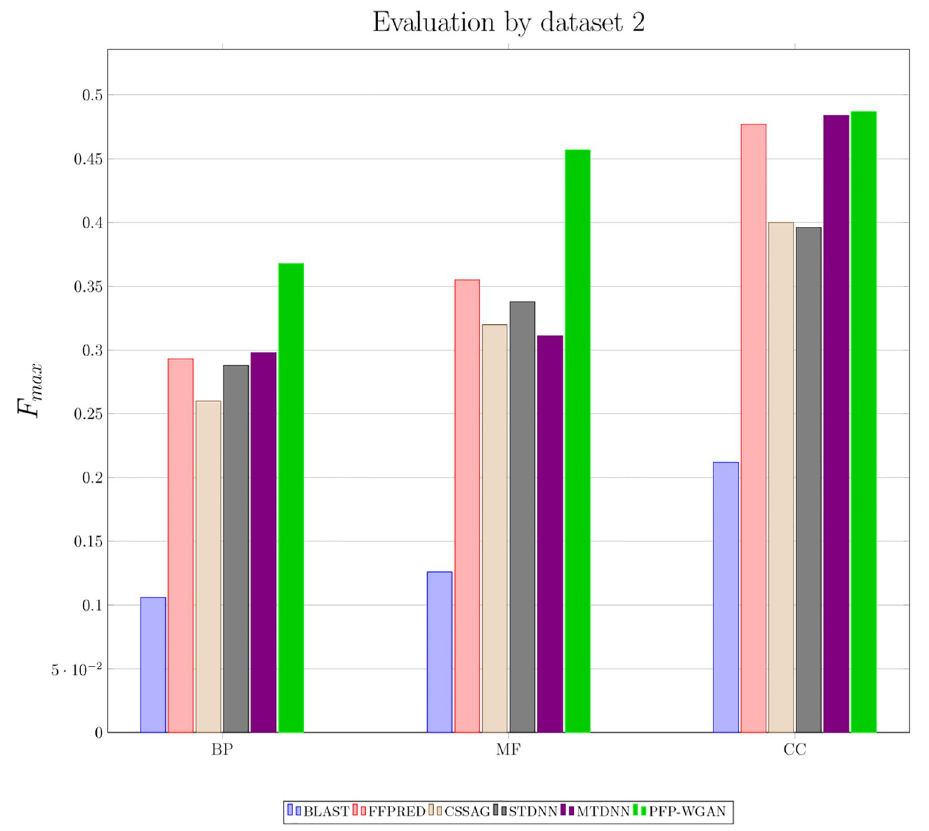
Fig 5. Comparison of BLAST, FFPRED, CSSAG, STDNN, MTDNN and PFP-WGAN on dataset 2. The F measure shows the superiority of PFP-WGAN in all three parts of the GO.